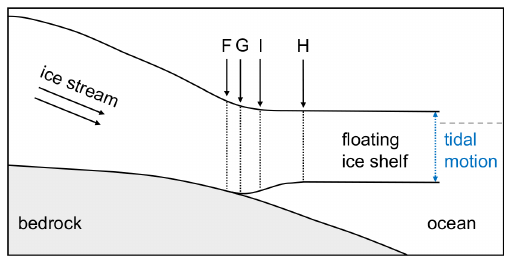
Figure 1. Schematic of the ice shelf grounding zone structure adapted from Fricker and Padman (2006). Point G is the true grounding line, Point F is the landward limit of ice flexure induced by tidal motion, Point H is the seaward limit of ice flexure and the inshore limit of hydrostatic equilibrium, and Point I is the break in surface